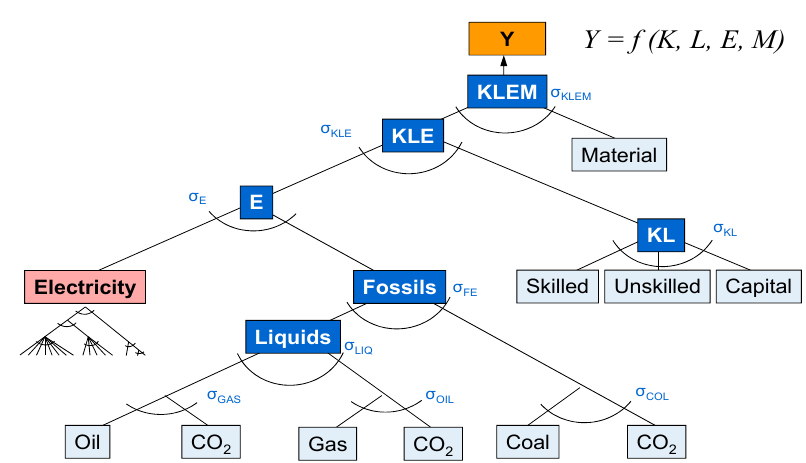
Figure A2. CES structure in NEWAGE for the production sectors.